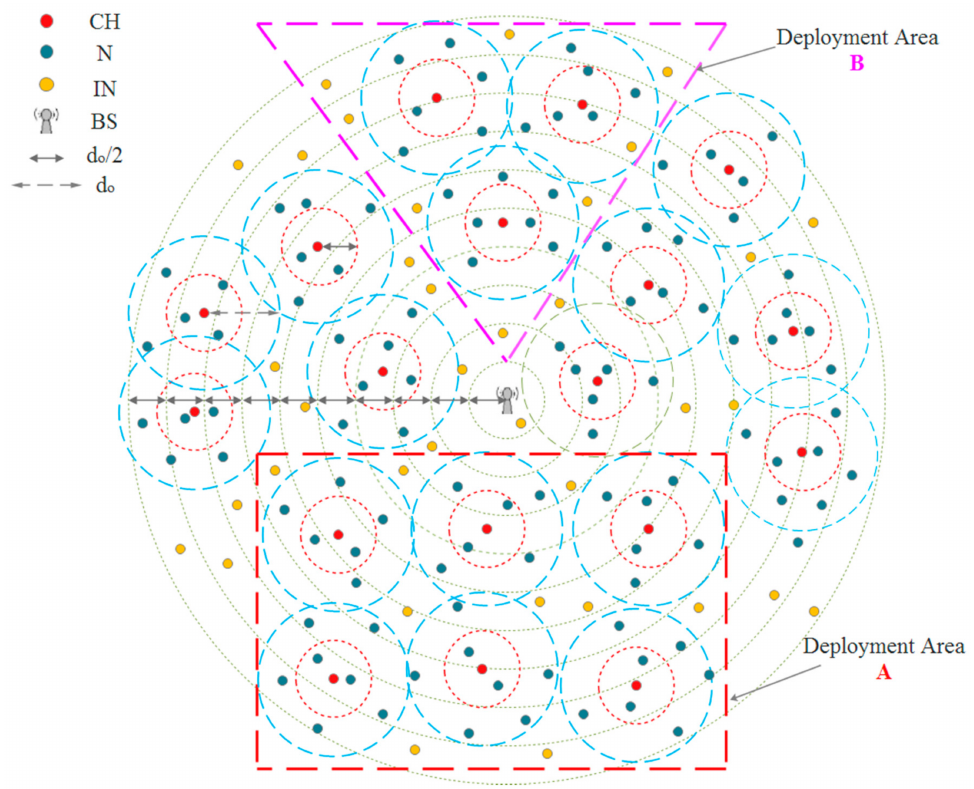
Figure 2. The general topology of a WSN using the proposed approach.